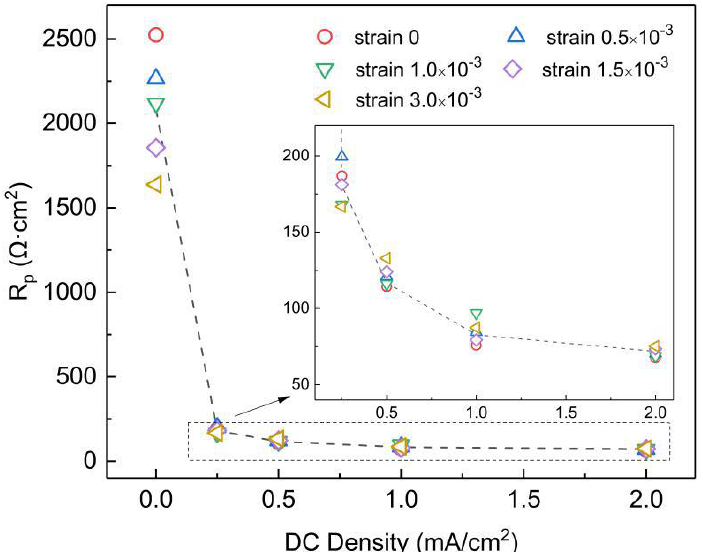
Figure 5. Variations in R p values of X80 steel sample in NS4 solution under different DC densities and applied strains (obtained from linear polarization scan).